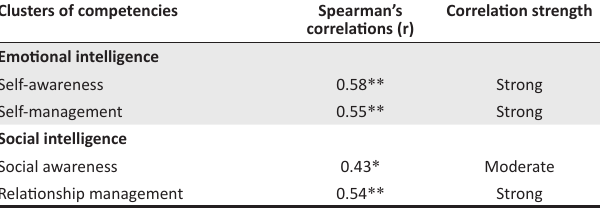
TABLE 4: Result of Spearman’s correlation to determine the relationship between leadership performance and emotional intelligence clusters.